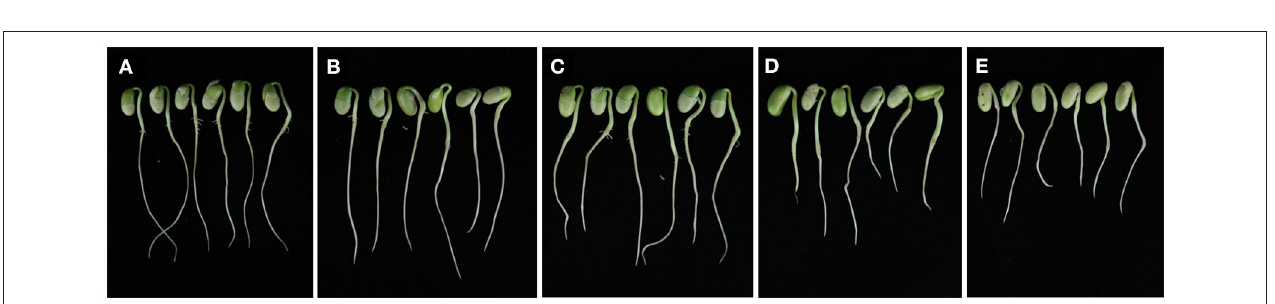
FIGURE 1 | The six-point scale system used to calculate disease severity. Leaves are scored 0 (A) , 1 (B) , 2 (C) , 3 (D) , 4 (E) , or 5 (F) on the disease severity scale.